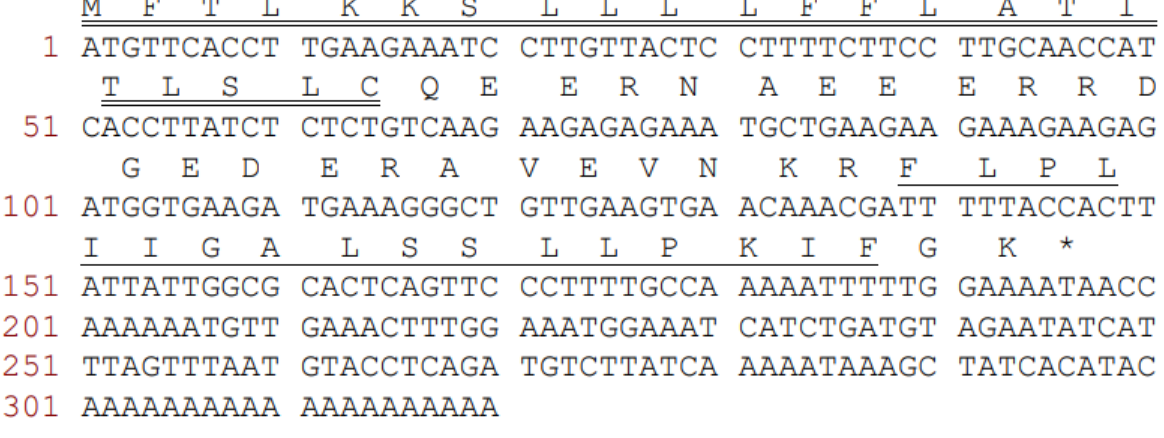
Table 1. The sequences and bioactivities of several peptides in the temporin